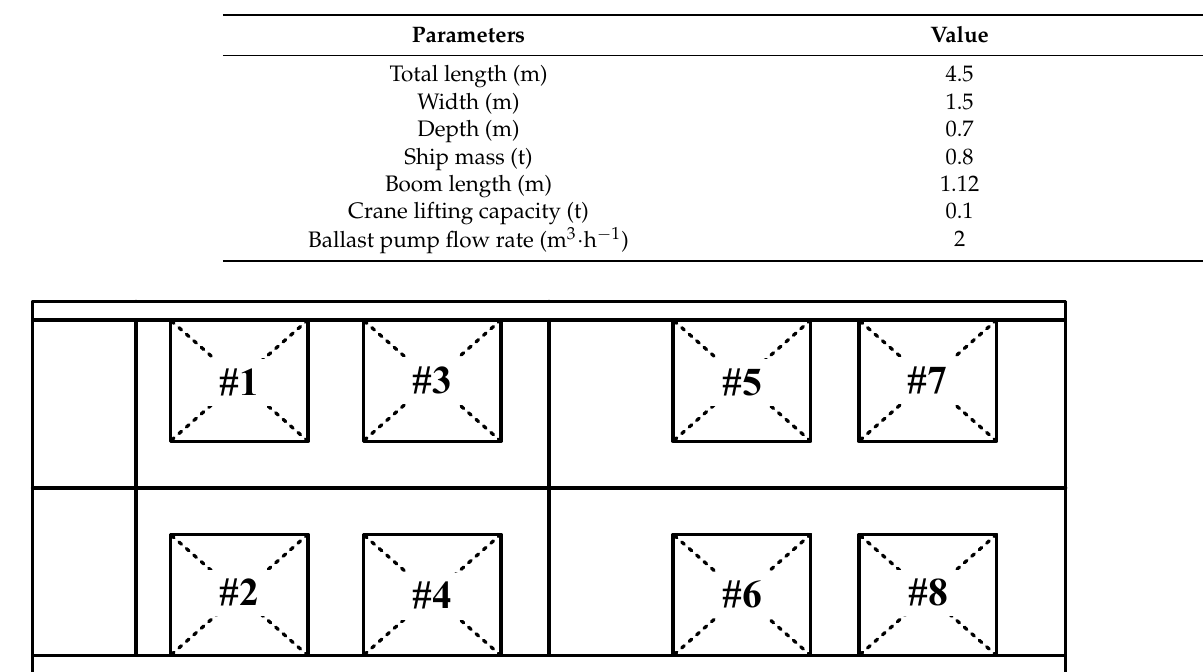
Table 2. Parameters of the experimental RFC.